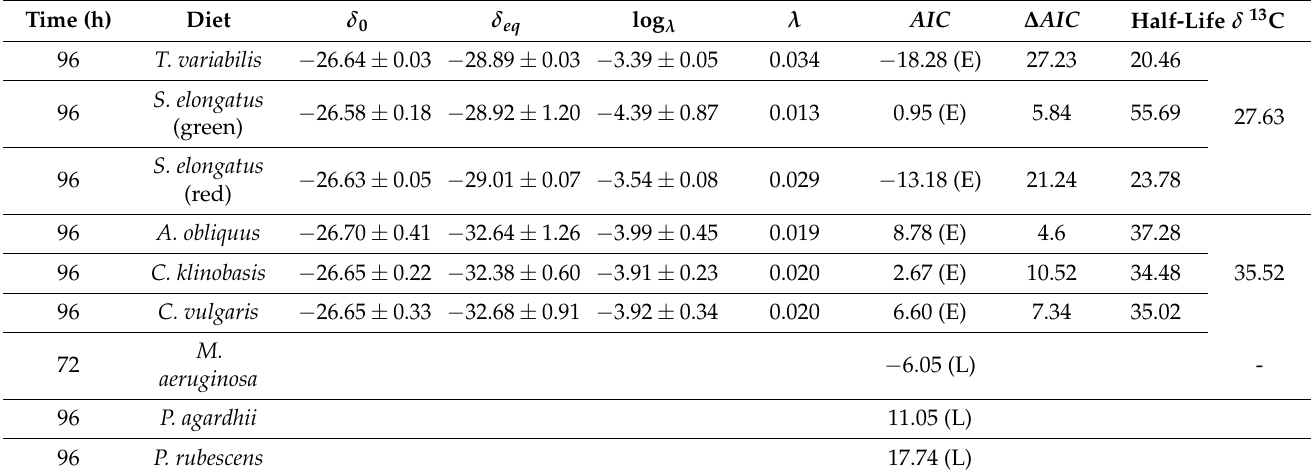
Table 4. Parameter estimates and standard errors of the linear and exponential decay function fitted to the δ 13 C values of D. magna samples fed on different dietary sources over an experimental time period of 96 h and a comparison with Akaike’s Information criterion corrected for the small sample size ( ∆ AICc). Here, δ 0 it the initial isotopic ratio of the experiment, δ eq is the asymptote (plateau) of the isotopic ratio, and λ is the incorporation rate of δ 13 C. The models were fitted using a time-based model for each dietary source ( n = 3) and for pooled data for the three diets ( n = 9), respectively. E = exponential decay model; L = linear decay model.